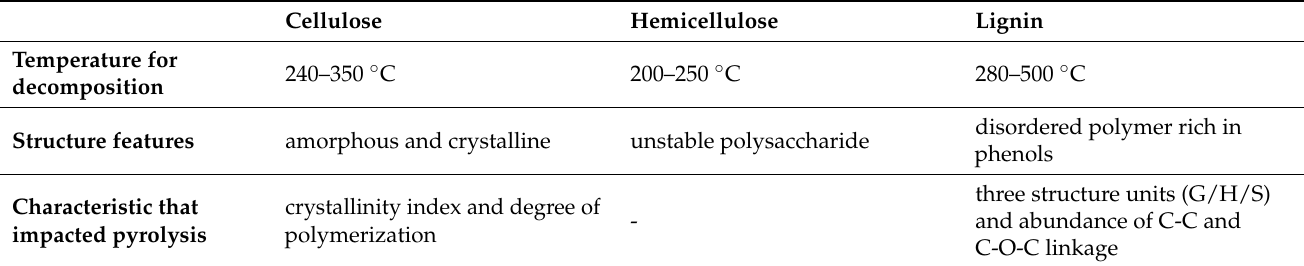
Table 2. The comparison of the three main components in pyrolysis